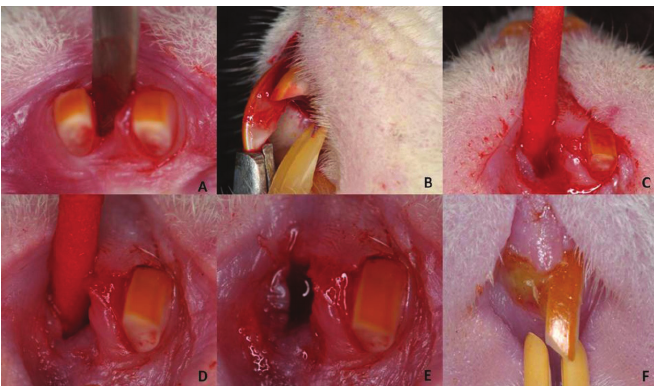
FIGuRE 1 - Experimental dry socket induction in rats: A ) Luxation of right maxillary incisor; B ) Extraction; C ) Application of adrenaline solution 1:1000 1 minute; d ) Inoculation of purulent secretion into the socket; E ) Socket aspect after ischemia and contamination; F ) Socket aspect after 3 days of contamination showing pus and gingival edema.